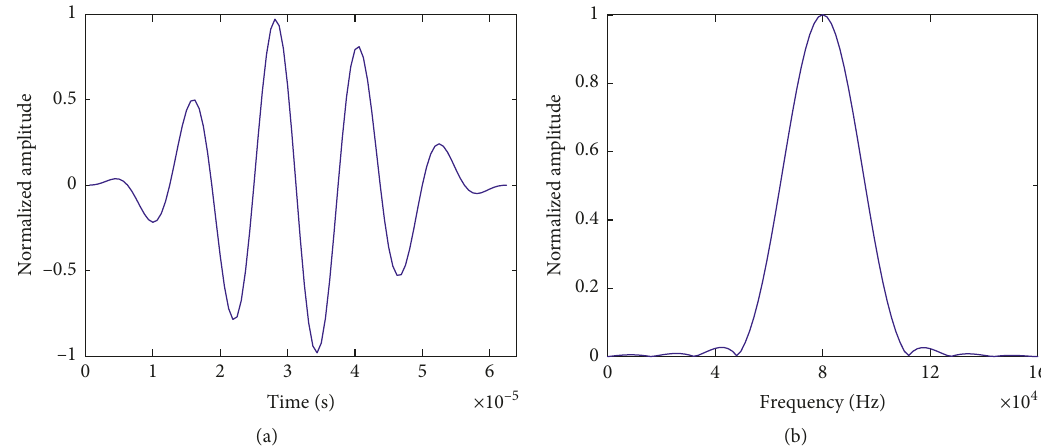
Figure 5: Narrowband tone-burst excitation: (a) 5-cycle tone burst at a central frequency 80kHz; (b) FFT of the excitation wave.